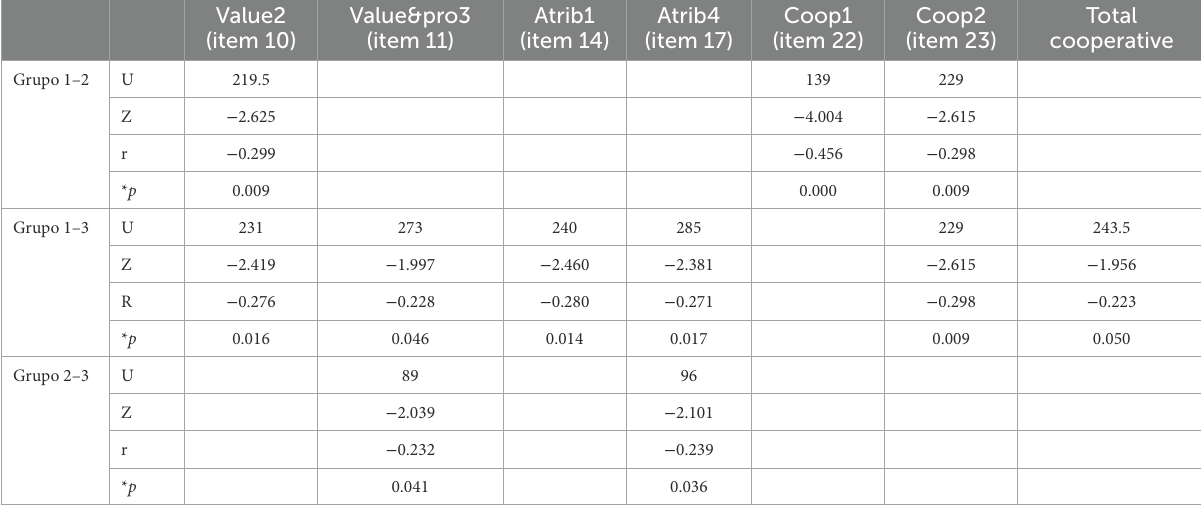
TABLE 11 Post-hoc Mann–Whitney U -Test to evaluate how motivation depends on teaching